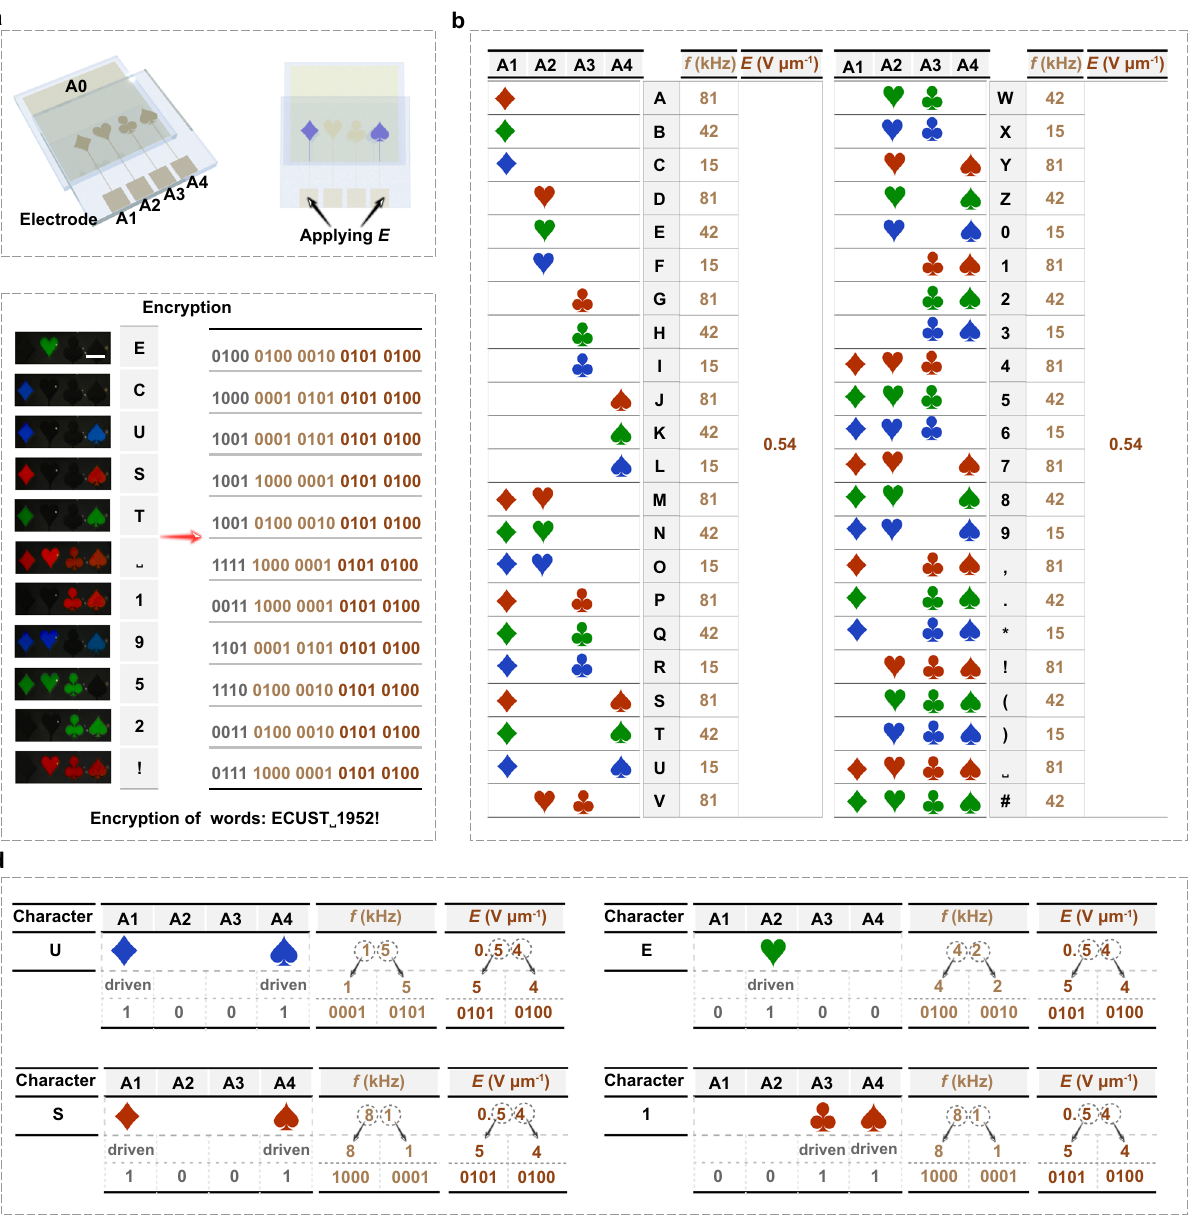
Fig. 4 Encoding and decoding process of the information encoder. a Schematic diagram of pattern design for information encoding. Four active areas with different Poker patterns were predesigned on the upper substrate of a single LC cell by etching the corresponding patterned indium tin oxide (ITO) on one substrate (A1, A2, A3 and A4) while a planar ITO (A0) on the other substrate as a common electrode. These active areas can be independently driven by an applied electric signal ( E ). b The encoding table describing the one-to-one correspondence between the speci fi c patterns and the characters. c The experimental patterns representing a series of words “ ECUST ˽ 1952! ” were encrypted with binary codes. The scale bar is 5 mm. d The decryption rules of the characters (such as “ U ” , “ S ” , “ E ” and “ 1 ” ) were formulated with 20 bits binary codes, where the fi rst 4 bits represented four active areas from the left to right, the driven area denoted “ 1 ” and the non-driven area was “ 0 ” . The frequency of driven signal was expressed by the middle 8 bits, in which the former and latter 4 bits represented the ten digits and single digits of the frequency respectively. In addition, the fi nal 8 bits denoted the fi eld strength of driven signal, in which the deciles and percentiles were the former and latter 4 bits. “ ˽ ” means the “ space ”